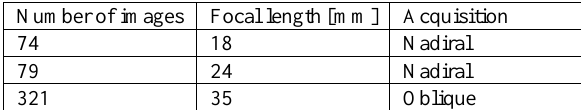
Table 8 . Characteristics of the photogrammetric dataset related to the 2007 survey.